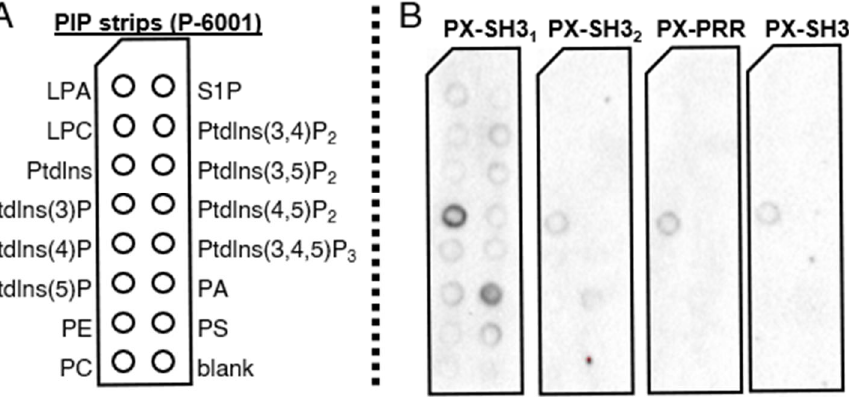
Figure 7. PX domain-containing Tks4 fragments bind phosphatidylinositol (3)-phosphate and phos- phatidic acid in a protein–lipid overlay (“PIP strip”) assay. ( A ) Schematic representation of the PIP strip membrane. LPA: lysophosphatidic acid, LPC: lysophosphatidylcholine, PtdIns: phosphatidyl- inositol, PtdIns(3)P: phosphatidylinositol (3)-phosphate, PtdIns(4)P: phosphatidylinositol (4)-phos- phate, PtdIns(5)P: phosphatidylinositol (5)-phosphate, PE: phosphatidylethanolamine, PC: phos- phatidylcholine, S1P: sphingosine 1-phosphate, PtdIns(3,4)P 2 : phosphatidylinositol (3,4)-bisphos- phate, PtdIns(3,5)P 2 : phosphatidylinositol (3,5)-bisphosphate, PtdIns(4,5)P 2 : phosphatidylinositol (4,5)-bisphosphate, PtdIns(3,4,5)P 3 : phosphatidylinositol (3,4,5)-trisphosphate, PA: phosphatidic